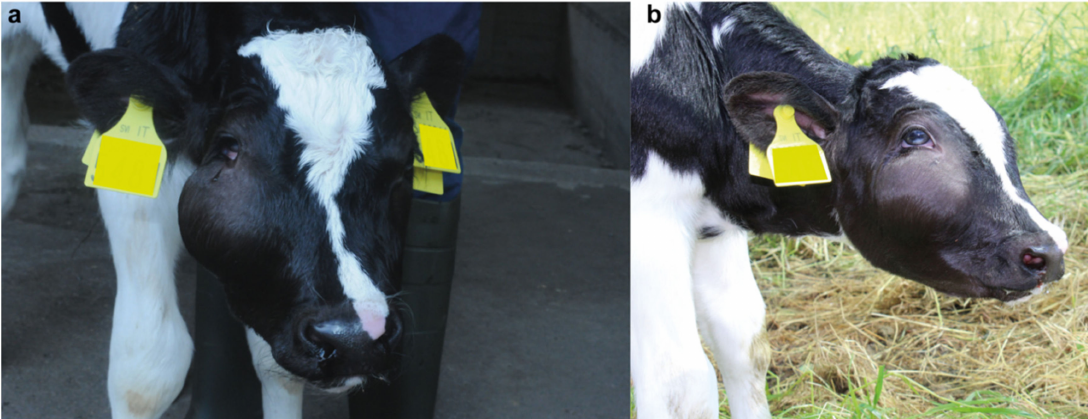
Figure 1. Calf showing the right sub-orbital subcutaneous mass ( a ) Frontal view of the calf. Note the presence of unilateral epistaxis and epiphora (right side). ( b ) Right lateral view of the calf. Note that the mass was delimited ventrally by the maxillary tuberosity and dorsally by the zygomatic arch compressing the lower eyelid and consequently inducing a deformation of the